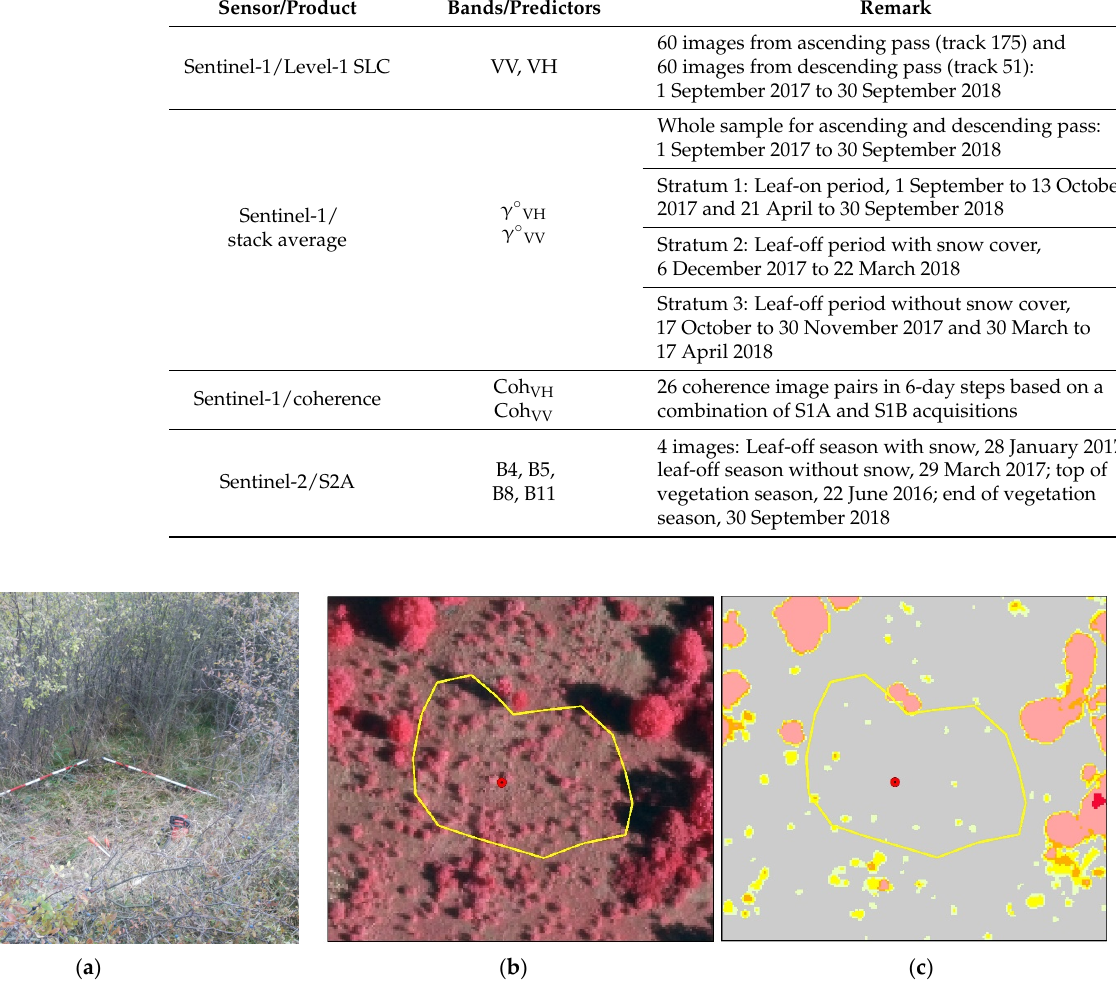
Table 3. Sentinel-1 and Sentinel-2 data and derived products used in the study. Sensor/Product Bands/Predictors